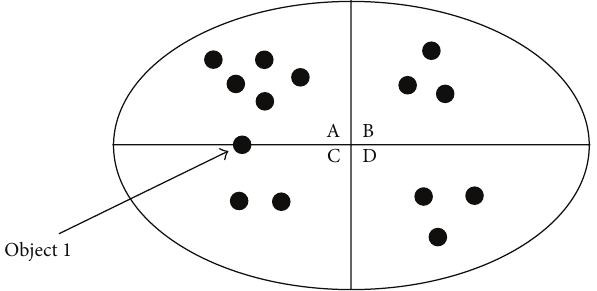
Figure 9: Example for the explanation of Fuzzy Clustering Method. Dots denote TC genesis locations in Areas A, B, C, and D.